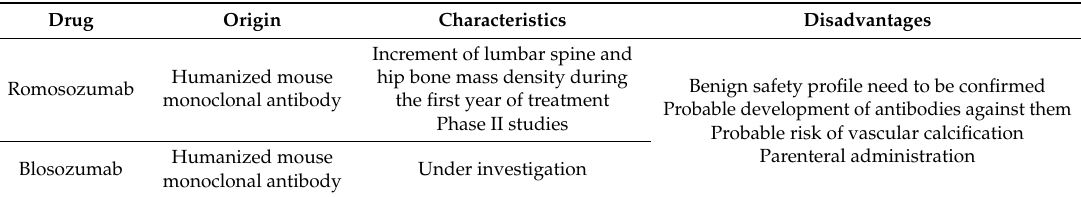
Table 7. Characteristics and disadvantages of sclerostin inhibitors